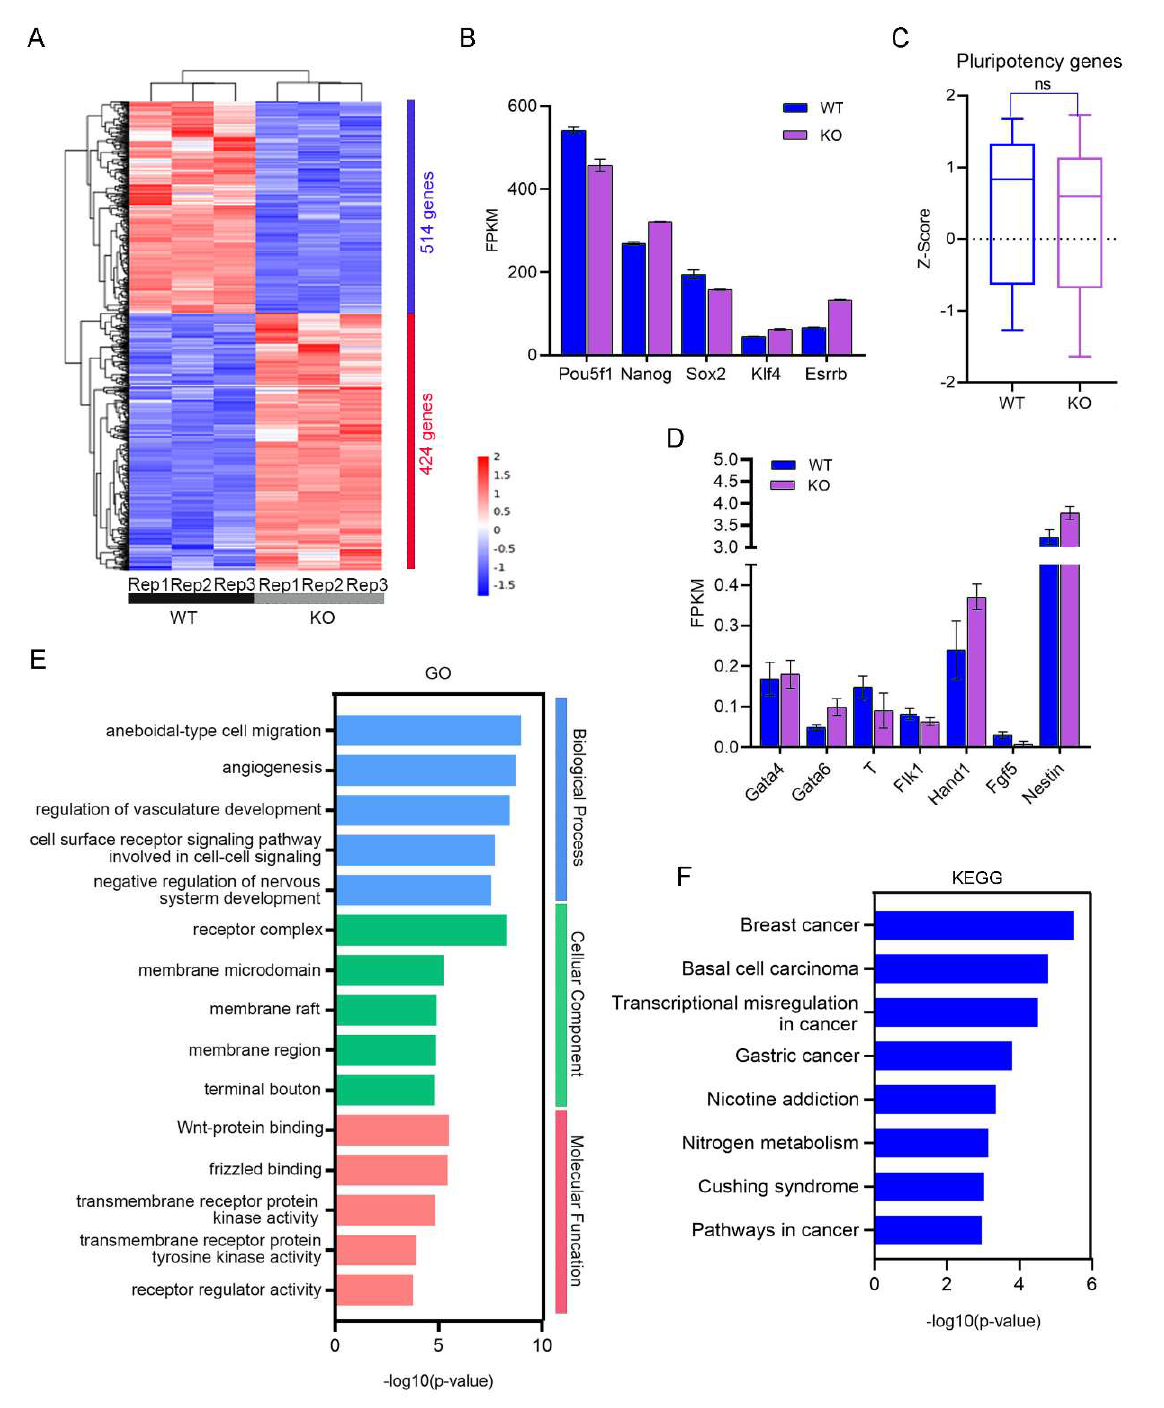
Figure 2. Transcriptome analysis using RNA-seq in Snap29 +/+ and Snap29 − / − KO ESCs. ( A ) Heatmap illustrating differentially expressed genes (DEGs) between Snap29 +/+ and Snap29 − / − ESCs. WT and KO-2 ESCs were used here, and three biological replicates were analyzed per group. Genes with ≥2-fold expression changes, and P adj < 0.05 were chosen for the heatmap. ( B ) Expression levels (FPKMs) of pluripotency genes in Snap29 +/+ and Snap29 − / − ESCs. ( C ) Z-scores of genes that were required for pluripotency maintenance [6]. ( D ) FPKMs of lineage marker genes in Snap29 +/+ and Snap29 − / − KO ESCs. ( E ) GO analysis of DEGs between Snap29 +/+ and Snap29 − / − ESCs. ( F ) The enriched KEGG pathways of DEGs between Snap29 +/+ and Snap29 − / − ESCs. Mean ± SEM from three biological replicates.